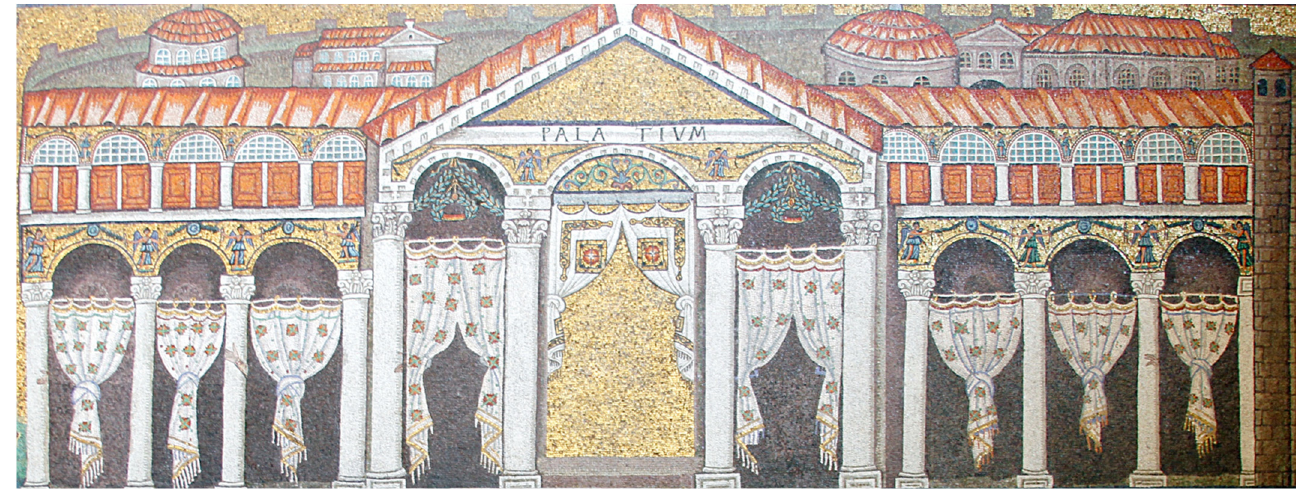
Figure 2. Wall mosaic depicting the Palace of Theodoric, c. 526 CE. Byzantine; Basilica of Sant’Apollinare Nuovo, Ravenna. © José Luiz Bernardes Ribeiro. Digital image available under Creative Commons license CC BY-SA 4.0 (https://commons.wikimedia.org/wiki/File:Theodoric%27s_Palace_-